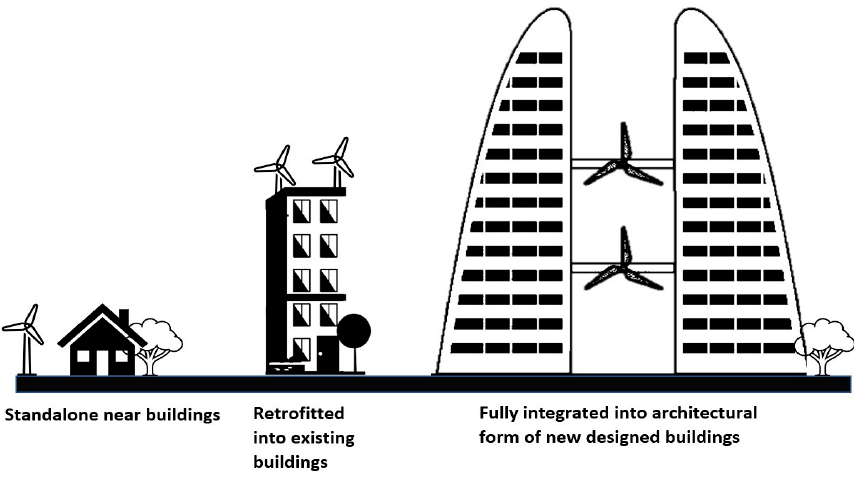
Figure 5. Categories of urban wind-energy-harvesting systems.